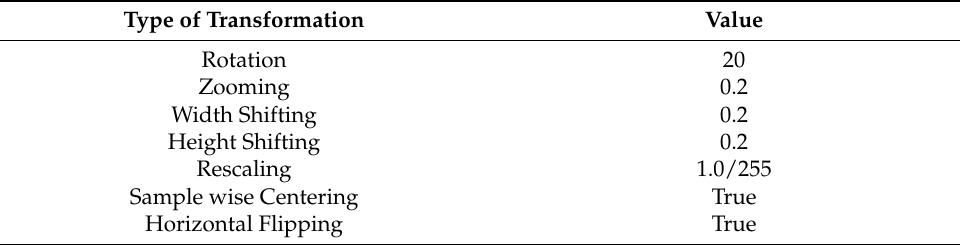
Table 2. Data augmentation techniques applied to the